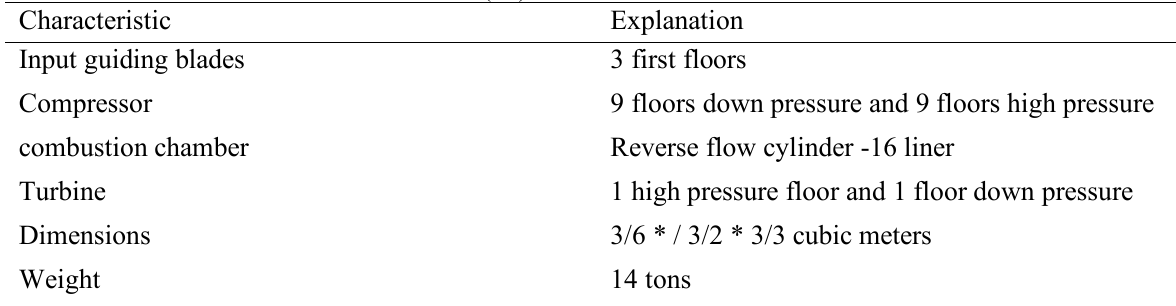
Table 1 . Characteristics of Turbine DU80